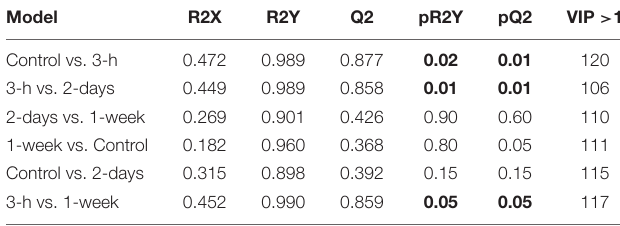
TABLE 4 | Supervised multivariate PLS-DA models computed from metabolites found in blood serum metabolome differentiating two groups.